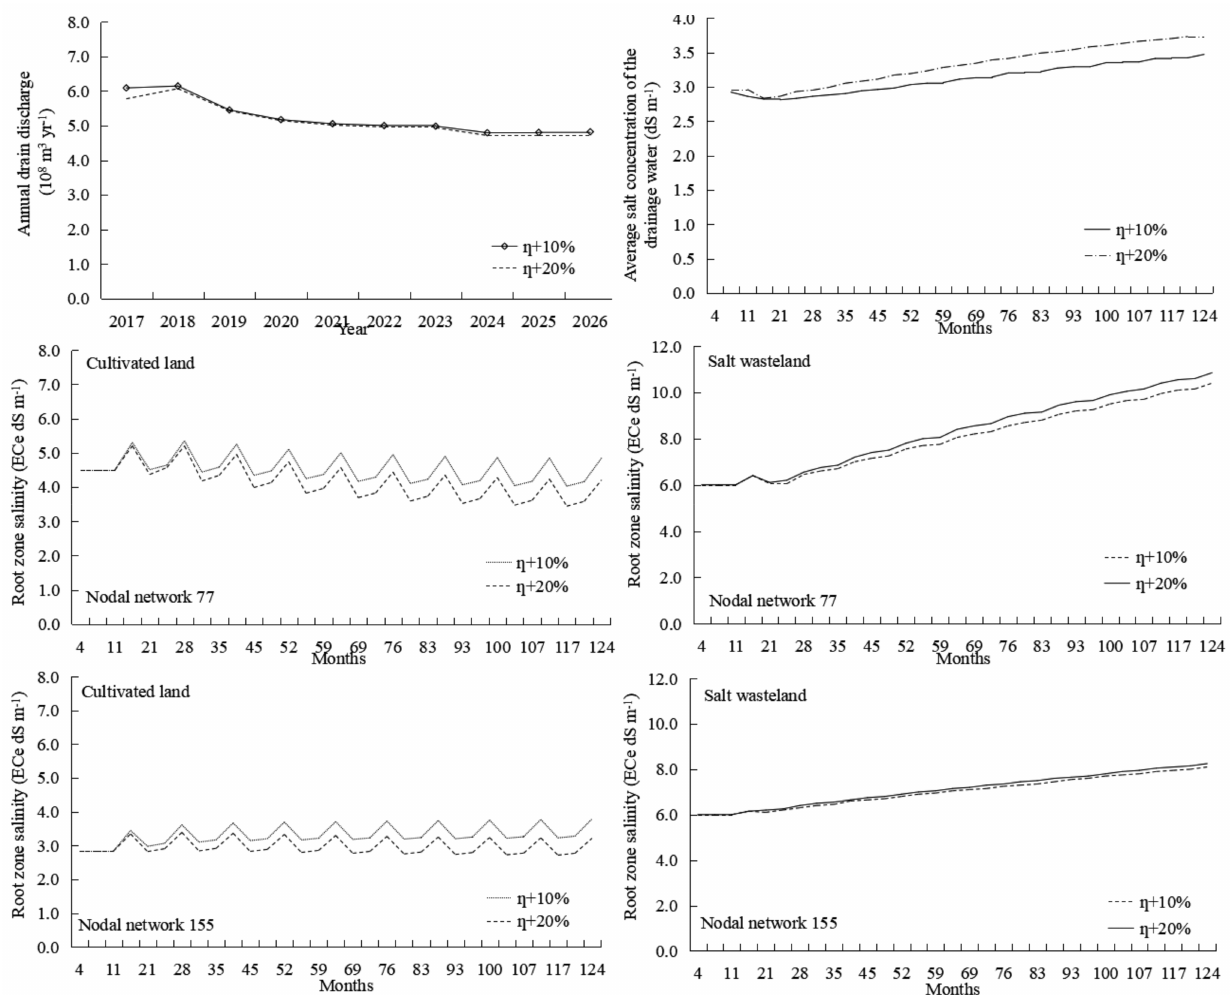
Figure 9. Variation of the annual drain discharge, drainage water salinity, and soil salinity dynamics of cultivated land and salt wasteland under different water efficiency of the canal